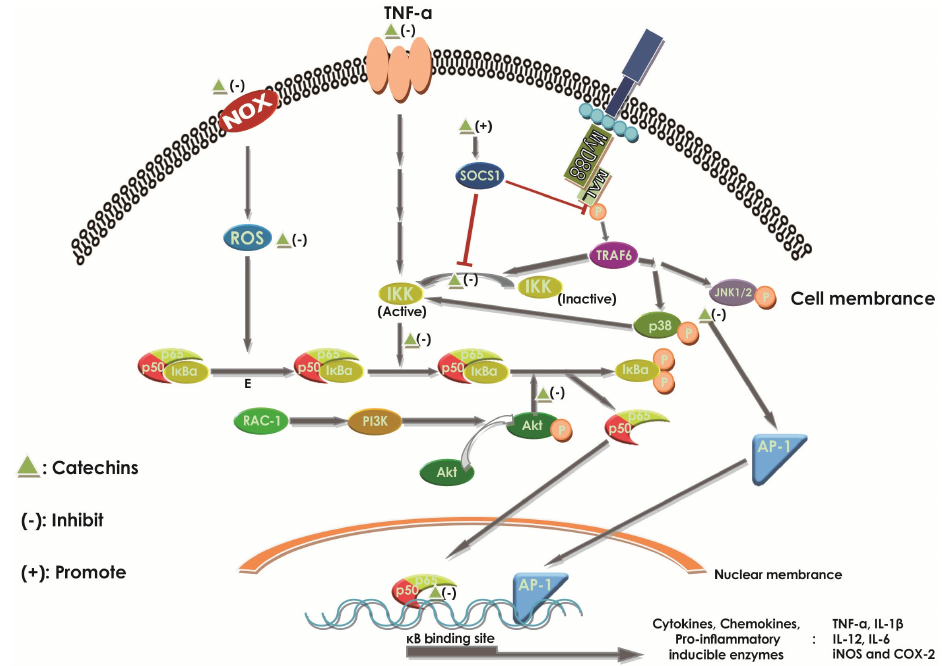
Figure 5. Catechins regulate the activation of NF- κ B at multiple levels. Catechins demonstrate direct inhibitory effect on the oxidant or inhibit the NF- κ B-related upstream NOX [10]. Also catechins can inhibit NF- κ B activation through IKK inactivation by several mechanisms such as up-regulating SOCS1 expression, which could impair inflammation. Catechins can inhibit the activation of NF- κ B by regulating the upstream protein kinases JNK1/2, p38, and PI3K/Akt etc. Inside the nucleus, catechins can interact with the DNA-binding site in the NF- κ B proteins, thus preventing gene transcription.